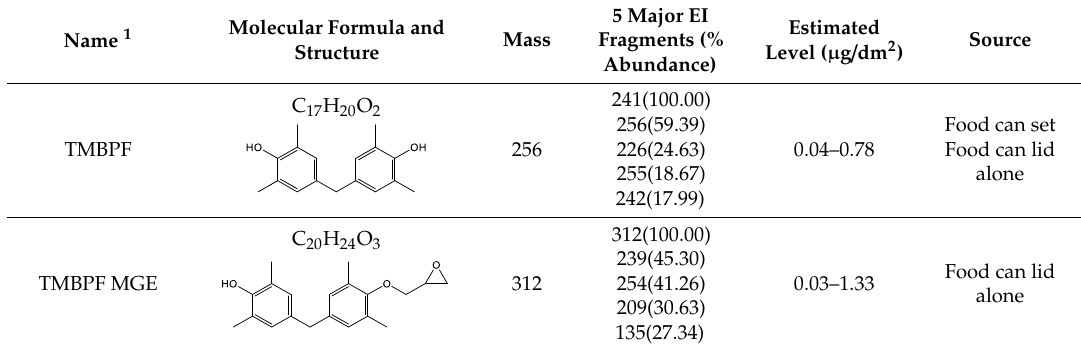
Table 2. Food-contact coating-borne migrants from metal cans (name, molecular formula, structure, mass, five major EI mass spectra fragment ion peak percent abundance, estimated concentration, and source).